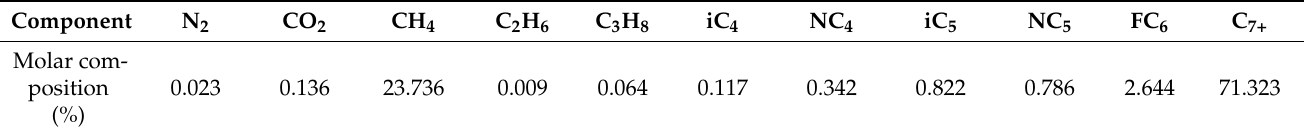
Table 1. Oil composition [42].